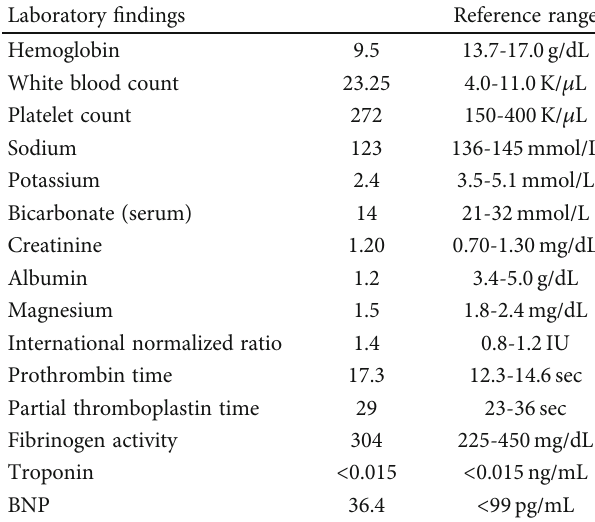
Table 1: Initial laboratory fi